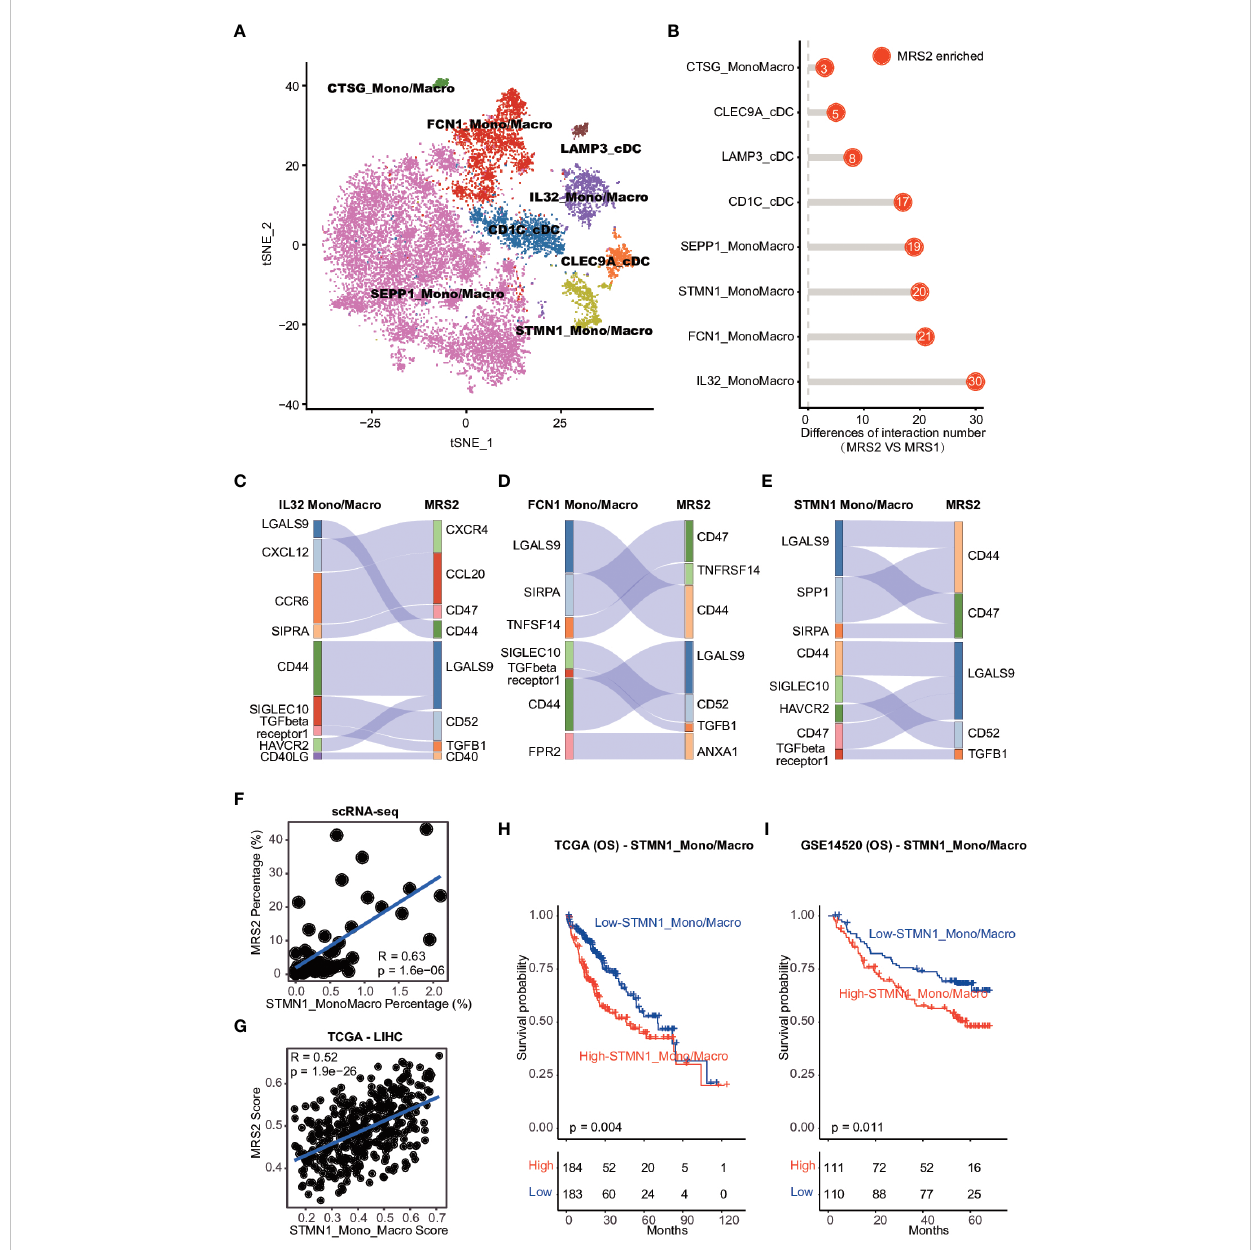
FIGURE 5 Cell-cell interaction between MRS2 cells and myeloid cells (A) t-SNE visualization of eight subpopulations of myeloid cells. (B) The difference in the number of ligand-receptor interactions between MRS1 and MRS2 cells. (C) Inhibitory interactions between IL32 + mono/macrophage and MRS2 cells. (D) Inhibitory interactions between FCN1 + mono/macrophages and MRS2 cells. (E) Inhibitory interactions between STMN1 + mono/macrophages and MRS2 cells. (F) Correlation between the percentage of STMN1 mono/macrophages and the fraction of MRS2 cells in HCC patients at single-cell level. (G) Correlation between the enrichment scores of STMN1 + mono/macrophages and MRS2 cells of HCC patients in TCGA-LIHC cohort. (H, I) Kaplan-Meier curves showing OS of HCC patients in TCGA-LIHC (H) and GSE14520 (I) cohorts. All patients were categorized into two groups based on the median of enrichment scores of STMN1 +